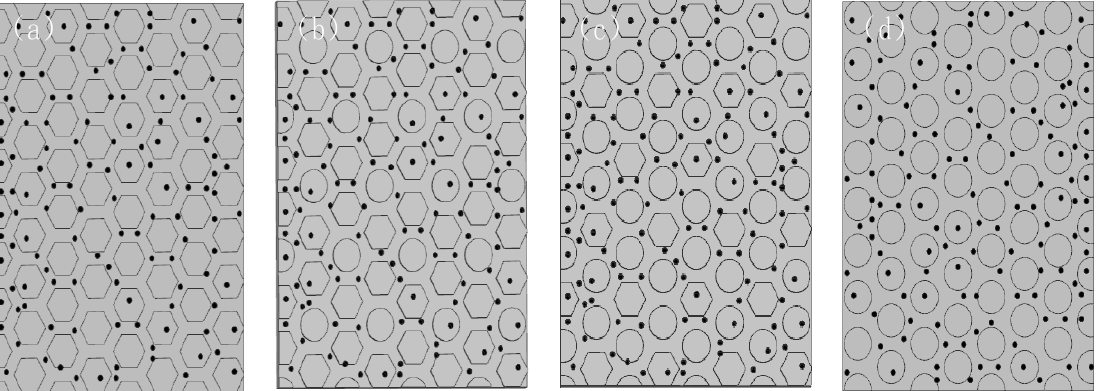
Figure 4. Micro-nano structure surface structure design drawing. ( a ) Regular hexagon, ( b ) hexagonal enclosing circle and ( c ) circle enclosing hexagonal ( d ) circle.